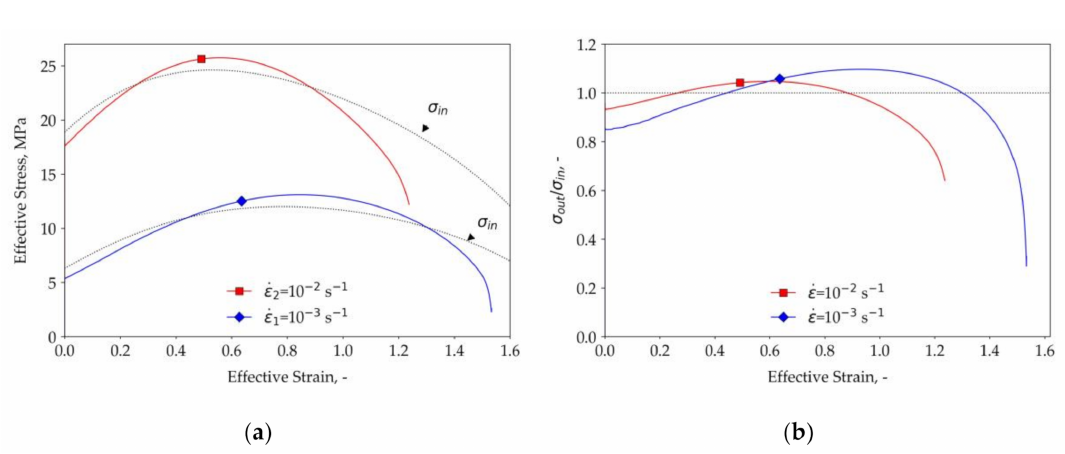
Figure 11. The relations of the input and the output stress on the e ff ective strain for the material model described by Equation (6): ( a ) the stress–strain curves for two di ff erent strain rates; ( b ) the normalized stress evolution for two di ff erent strain